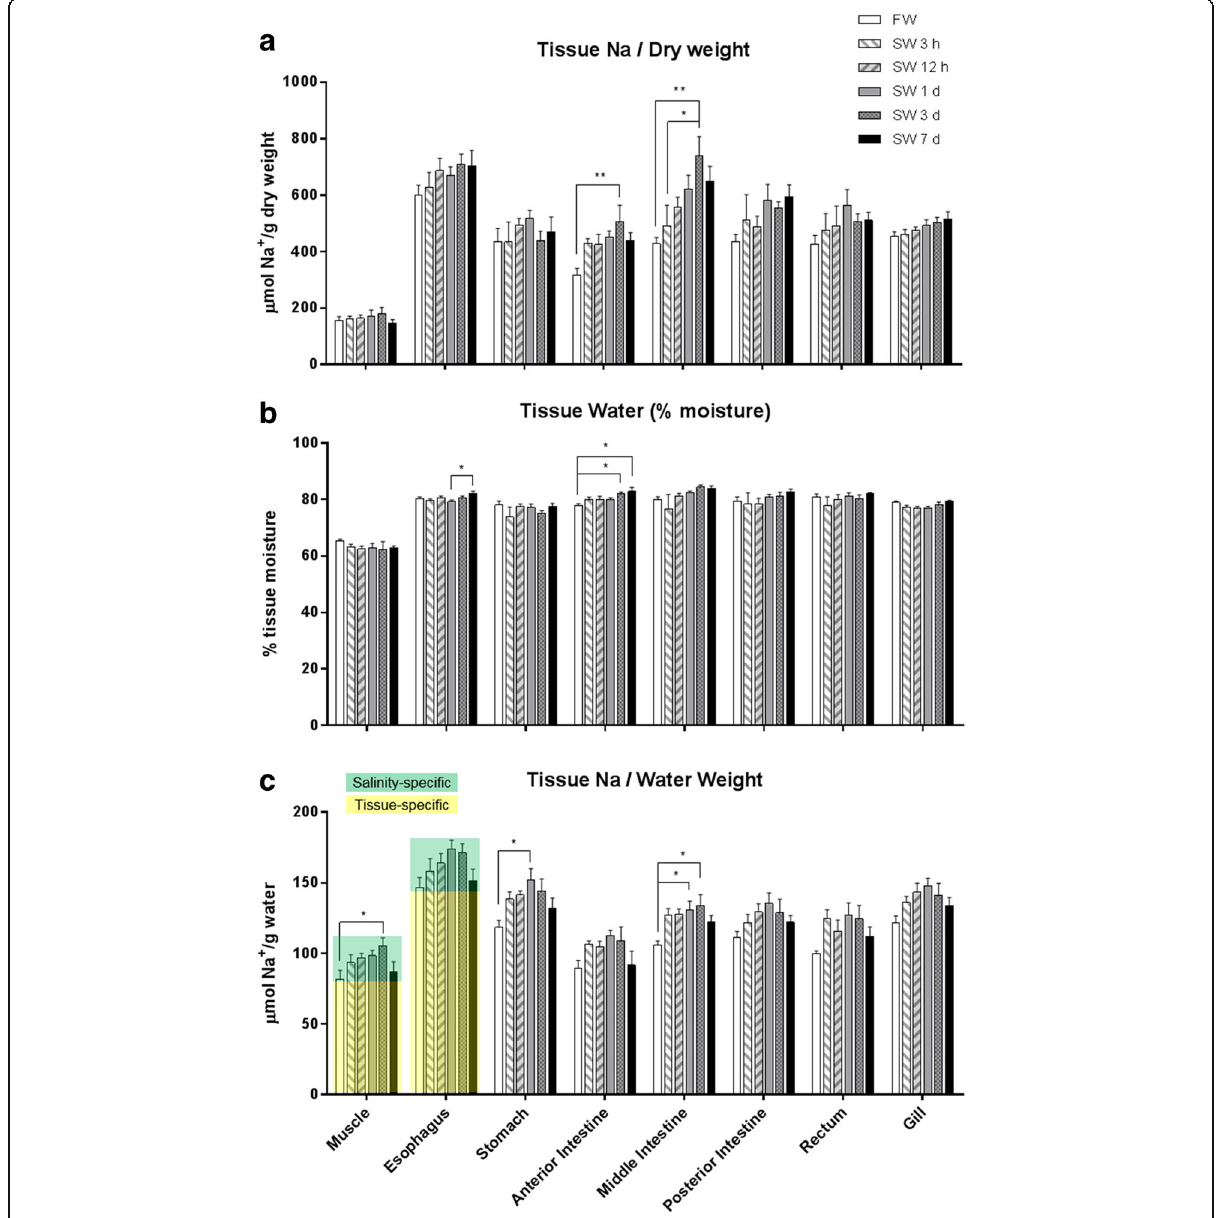
Fig. 3 Effects of time-course freshwater (FW) to seawater (SW) transfer on ( a ) tissue Na content, ( b ) tissue moisture, and ( c ) tissue Na concentration in eels. Green and yellow shadings indicates the salinity-specific changes and tissue-specific basal Na concentrations respectively in representative tissues. Statistical differences of salinity transfer ( N = 6) are indicated by * ( p < 0.05) and ** ( p < 0.01) after one way ANOVA, Tukey ’ s